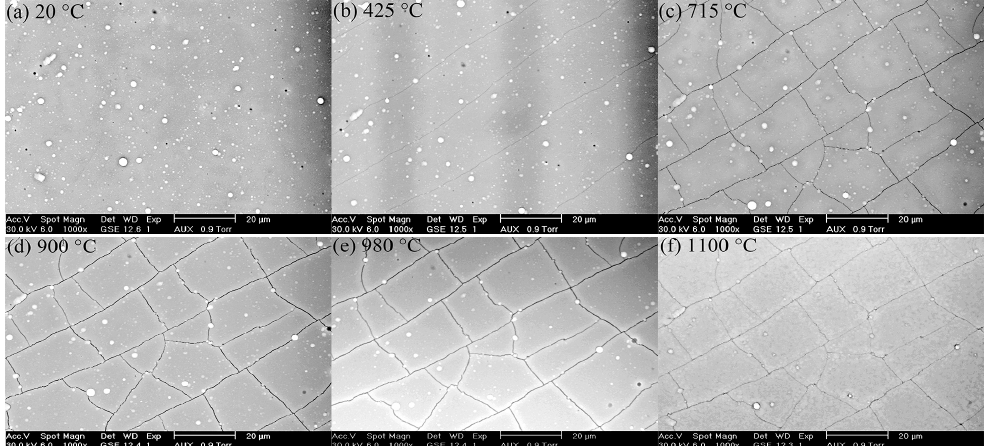
Figure 4. In-situ surface morphologies of the Cr 2 O 3 film heated at several typical temperatures: ( a ) 20 °C; ( b ) 425 °C; ( c ) 715 °C; ( d ) 900 °C; ( e ) 980 °C; and ( f ) 1100 °C.